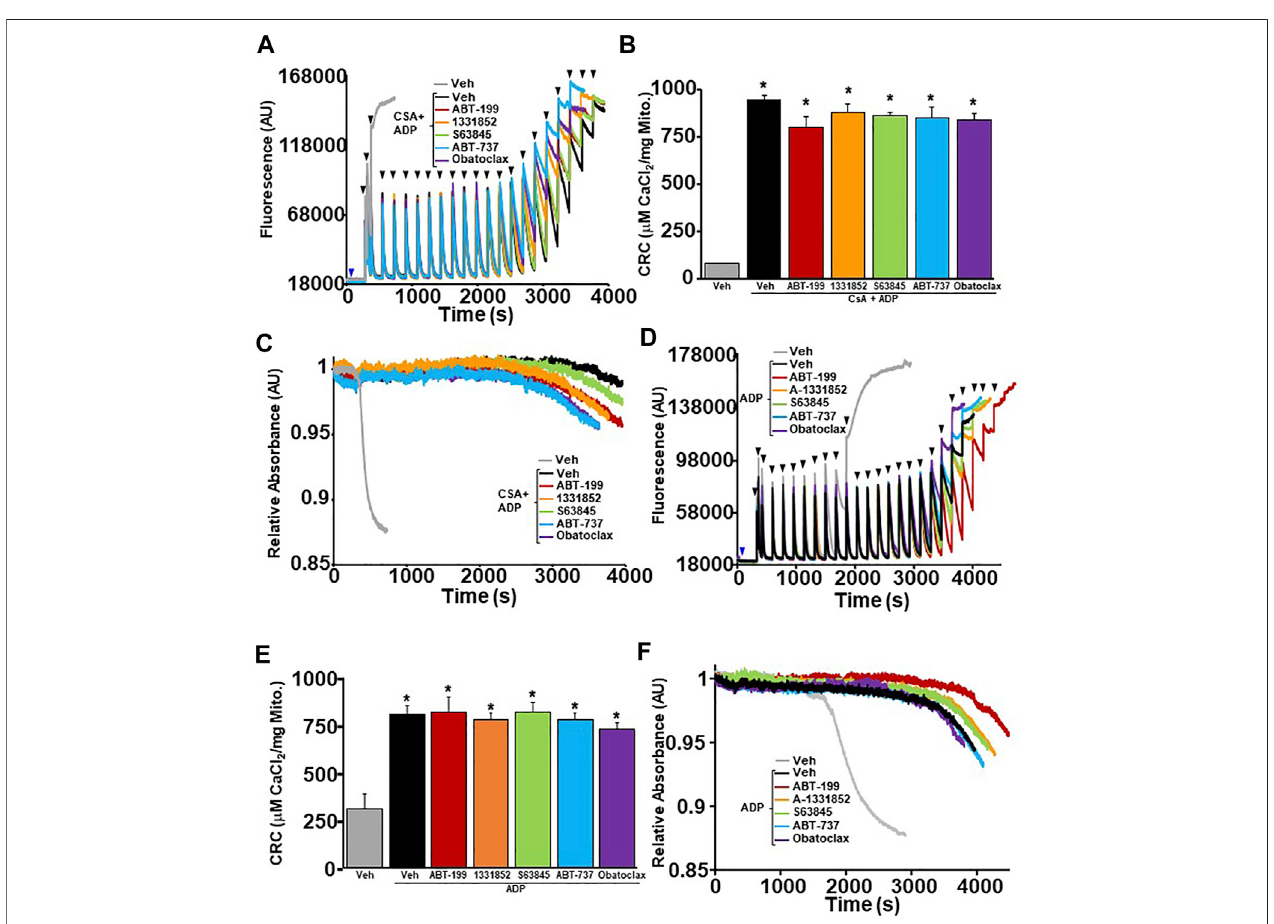
FIGURE 5 | MPTP inhibition by dual treatment of CsA and ADP prevents BH3 mimetics ability to effect mitochondrial CRC. (A) Representative traces of mitochondrial calcium uptake of WT liver mitochondria pre-treated with 300 µM adenosine diphosphate (ADP) and 2 µM cyclosporine A (CsA). Following a 5 min incubation, they were then treated with either 200 nM ABT-199 (red), 100 nM A-1331852 (orange), 10 nM S63845 (green), 100 nM ABT-737 (blue), 10 nM Obatoclax (purple),orwiththevehiclecontrol(black).ControlWTlivermitochondriawithoutADP+CsApretreatment isshown ingrey.Thebluearrow represents theaddition of the vehicle or BH3 mimetics. The black arrowheads represent the addition of 80 μ M CaCl 2. (B) Quanti fi cation of mitochondrial calcium retention capacity (CRC) was calculatedfrommitochondrialcalciumuptaketraces,asin (A) . (C) Correspondingmitochondrialswellingrepresentativetraceto (A) ofWTlivermitochondriapre-treated with ADP and then treated with BH3 mimetics and CaCl 2 . Three independent experiments ( n (cid:2) 3) were performed for every panel. * p ≤ 0.05 for comparison of the Veh without CsA and ADP treatment. (D) Representative traces of mitochondrial calcium uptake of CypD null liver mitochondria pre-treated with 300 µM ADP. Following a 5 min incubation, the mitochondira were then treated with either 200 nM ABT-199 (red), 100 nM A-1331852 (orange), 10 nM S63845 (green), 100 nM ABT-737 (blue), 10 nM Obatoclax (purple, or with vehicle control (black). Control CypD null liver mitochondria without ADP pretreatment is shown in grey. The blue arrow represents the addition of the BH3 mimetics or vehicle. The black arrowheads represent the addition of 80 µM CaCl 2 . (E) Quanti fi cation of mitochondrial CRC was calculated from mitochondrialcalciumuptaketraces,asin (D) . (F) Correspondingmitochondrialswellingrepresentativetraceto (D) of ppif − / − livermitochondriapre-treatedwithADPand then treated with BH3 mimetics and CaCl 2 . Three independent experiments ( n (cid:2) 3) were performed for every panel. p ≤ 0.05 for comparison of the Veh without ADP treatment.